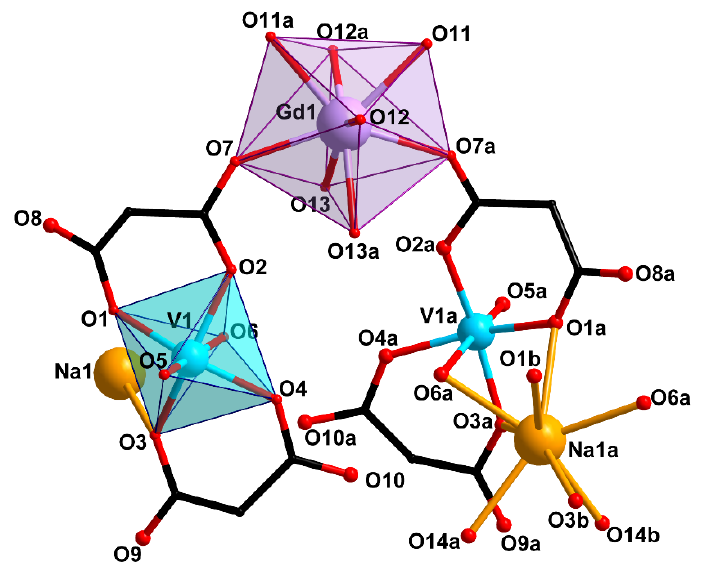
Figure 1. Structure of trinuclear unit {GdV 2 } − and Na atom environment in compound 1 (H atoms and cyclic fragments of the carboxylate ligands are not shown). [Symmetry codes: (a) 1 − x, y, 0.5 − z; (b) 1 + x, y, z].